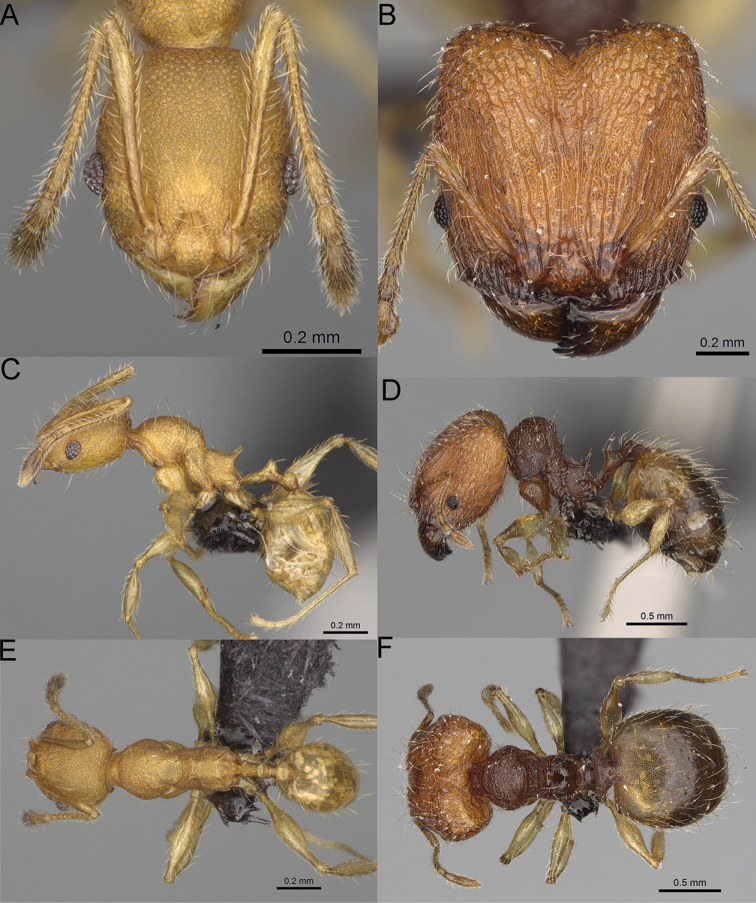
Pheidole
vohamarensis sp. nov., full-face view (A), profile (C), and dorsal view (E) of paratype minor worker (CASENT0107947) and full-face view (B), profile (D), and dorsal view (F) of holotype major worker (CASENT0107946).